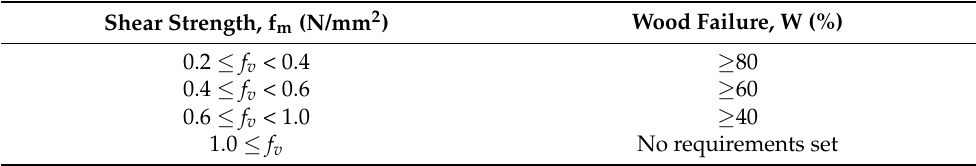
Table 1. Plywood glue line bonding